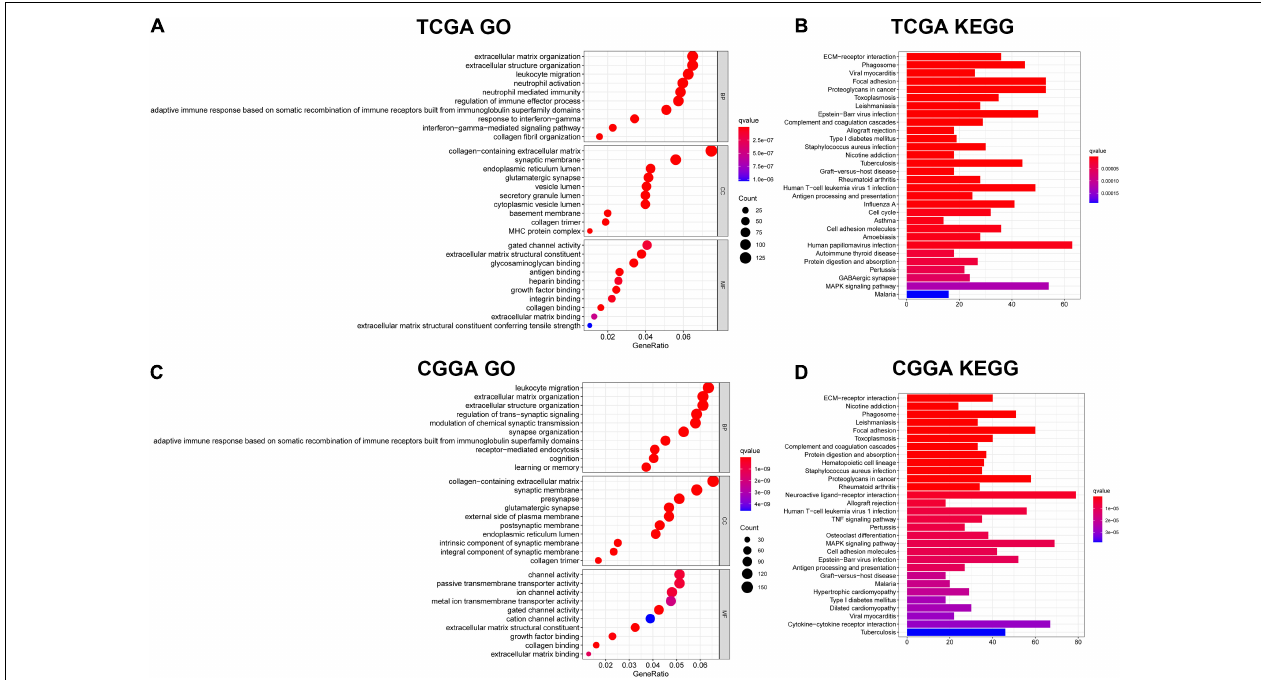
FIGURE 7 | Results of GO and KEGG analyses. (A) GO analysis in the TCGA dataset. (B) KEGG pathway analysis in the TCGA dataset. (C) GO analysis in the CGGA dataset. (D) KEGG pathway analysis in the CGGA dataset.